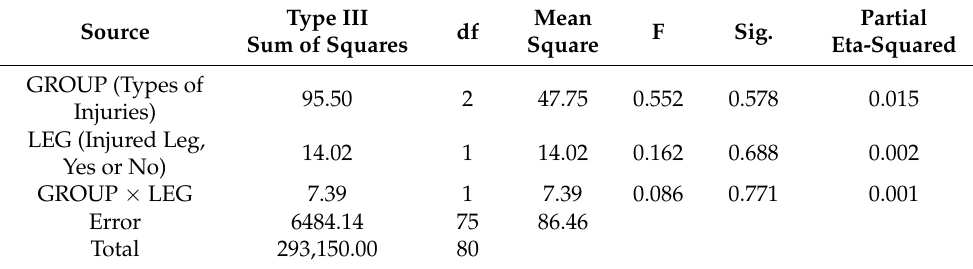
Figure 4. Comparison of ipsilateral strength ratios between observed groups. Note: ACL = anterior cruciate ligament group, HAM = hamstring group, and CONTROL = control group. Table 4. The effect of observed factors on the level of the unilateral strength ratio.